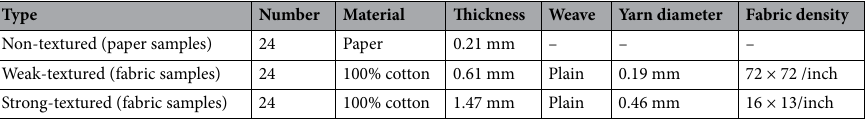
Table 1. Description of three types